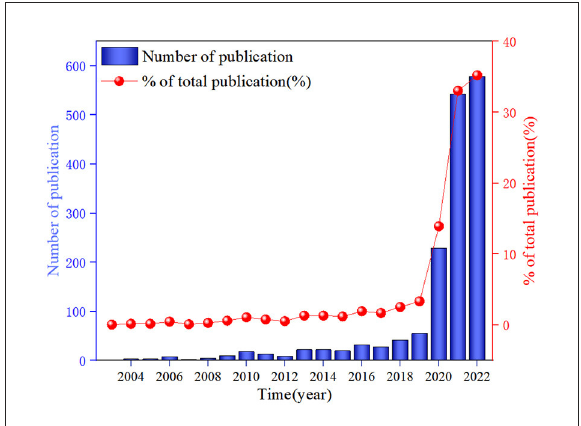
FIGURE2 The evolution of publication in emergency management of global public health emergencies driven by digital technology during 2003–2022.